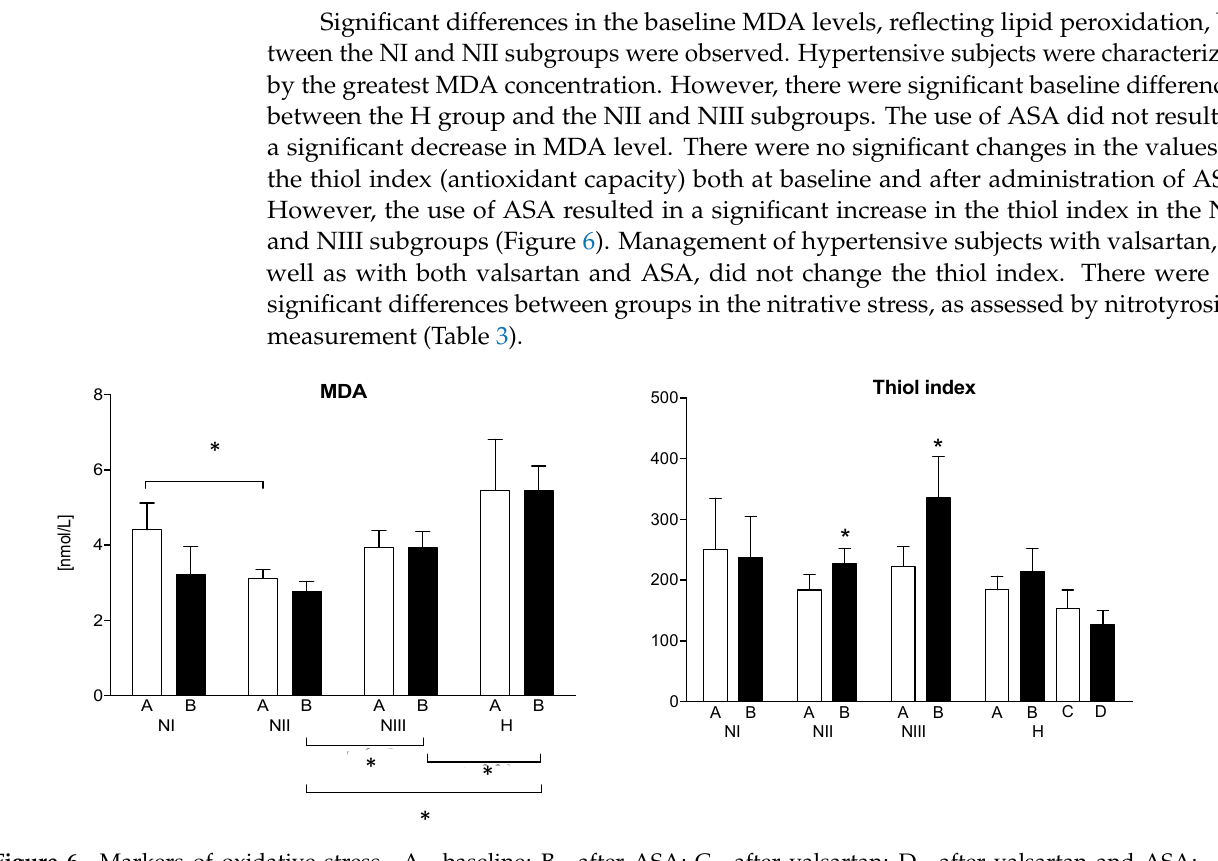
Figure 6. Markers of oxidative stress. A—baseline; B—after ASA; C—after valsartan; D—after valsartan and ASA; MDA—malondialdehyde. * p < 0.05 A vs. B as indicated; $ and $$—p < 0.05 and p < 0.001 vs. another subgroup at the same step of study protocol, respectively.